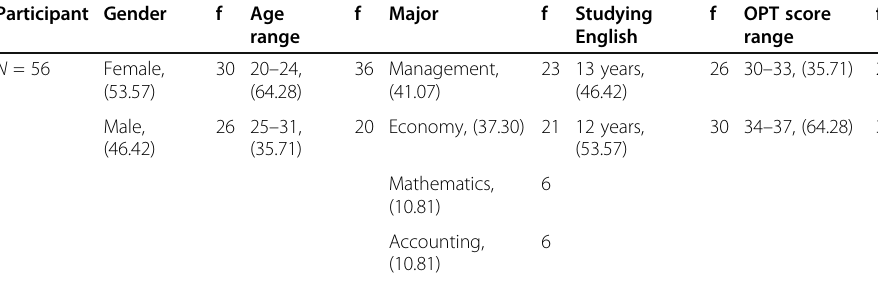
Table 1 Demographic attributes of the participants (%) Participant